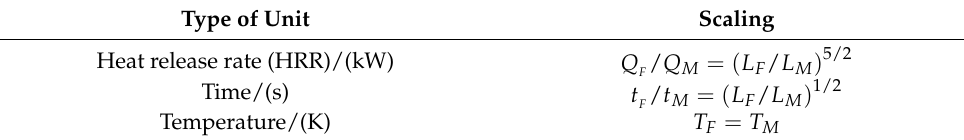
Table 1. A list of Froude scaling correlations.